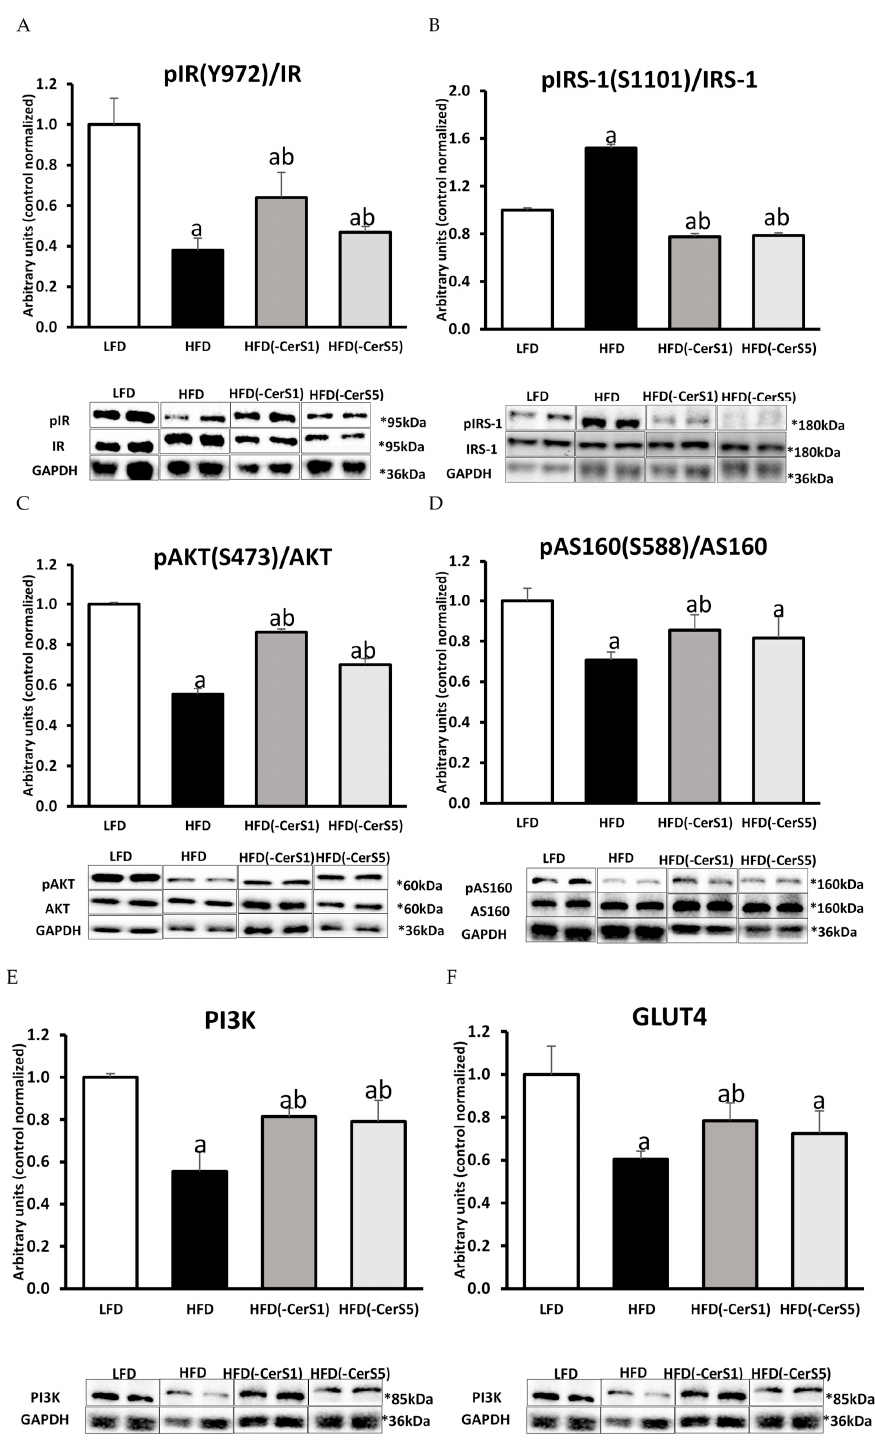
Figure 5. Activation of insulin signaling pathway in CerS1 and CerS5-silenced gastrocnemius muscle of HFD-fed mice: Panel A —insulin receptor tyrosine phosphorylation (pIR Y972); Panel B — IRS1 serine phosphorylation (pIRS S1101); Panel C —serine phosphorylation of protein kinase B/Akt (pAKT S473); Panel D —serine phosphorylation of Akt/PKB 160 kDa substrate (pAS160 S588); Panel E —protein expression of phosphoinositide 3-kinase (PI3K); Panel F —protein expression of glucotransporter 4 (GLUT4). Values are mean ± SD ( n = 8 per group); a— p < 0.05 vs. LFD; b— p < 0.05 vs. HFD; significance by ANOVA; LFD-low-fat diet, HFD—high-fat diet. The observed molecular weight of indicated proteins is different to the theoretical one, as stated by the antibody manufacturer .